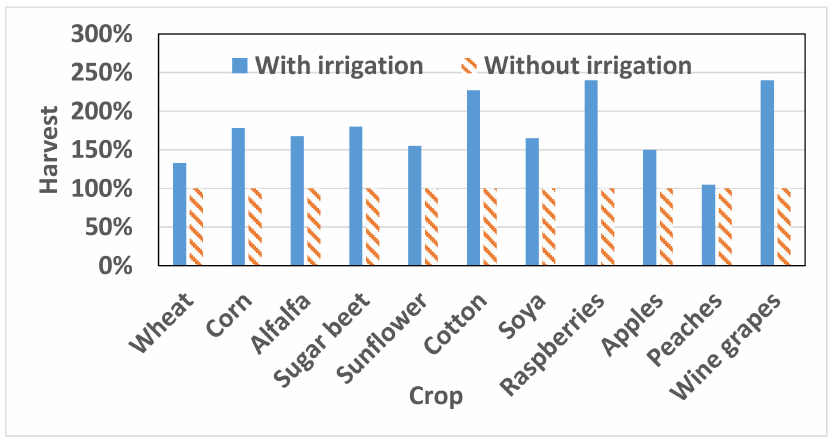
Figure 2. Influence of irrigation on the harvest for different crops